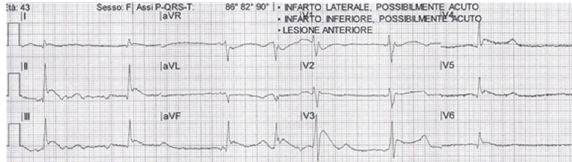
Figure 1: 12 lead EKG at EMS arrival (typical Osborn waves, also known as camel-hump sign, late delta wave, or hypothermic wave. Deflections are more commonly observed in leads II, III, AVF, V5, and V6).